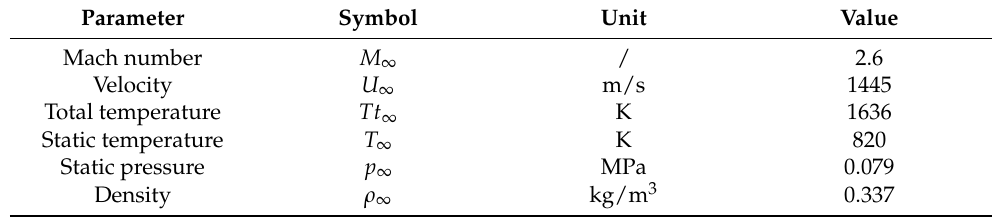
Table 1. Supersonic crossflow conditions.